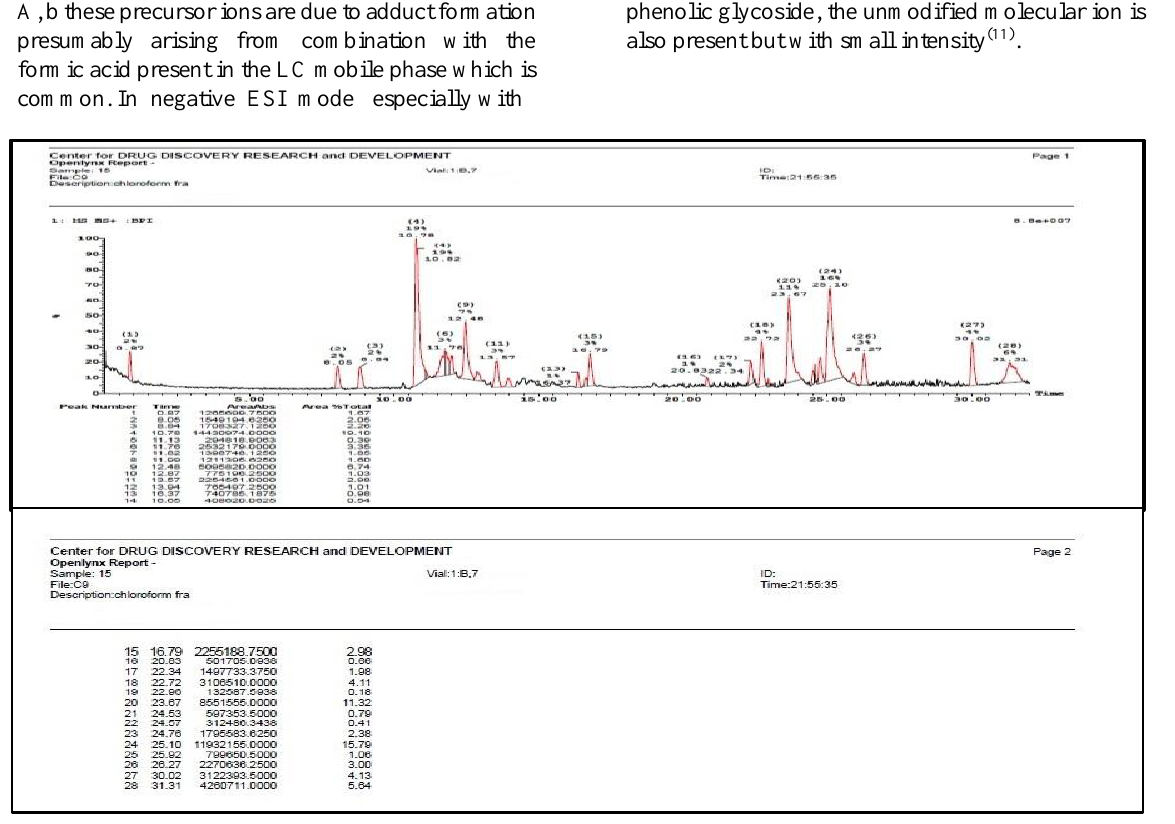
Figure10. UPLC chromatogram of chloroform fraction